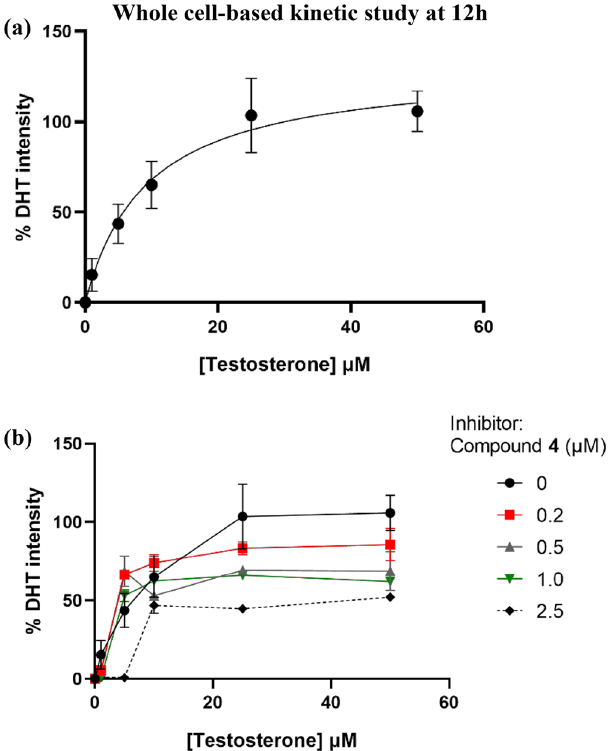
Figure 7. Whole-cell-based kinetic study of compound 4 on the inhibition of SRD5A1 in HaCaT cells at 12 h. ( a ) % dihydrotestosterone (DHT) intensity in variation of testosterone without compound 4 as an inhibitor. ( b )